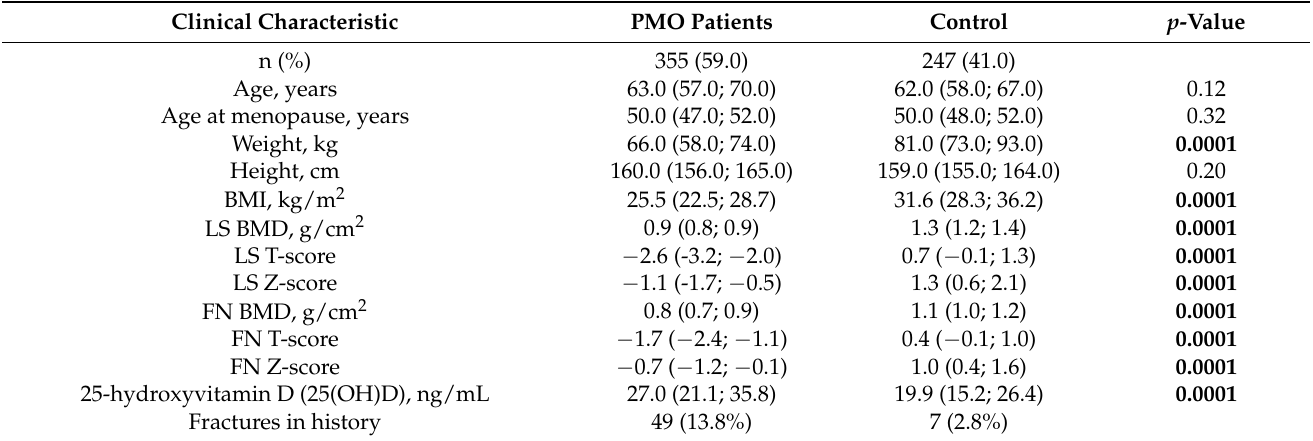
Table 1. Clinical characteristics of study